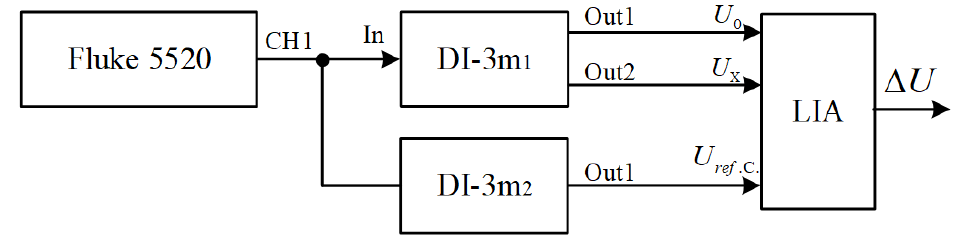
Figure 12. Flowchart of the maximum amplitude of the compared